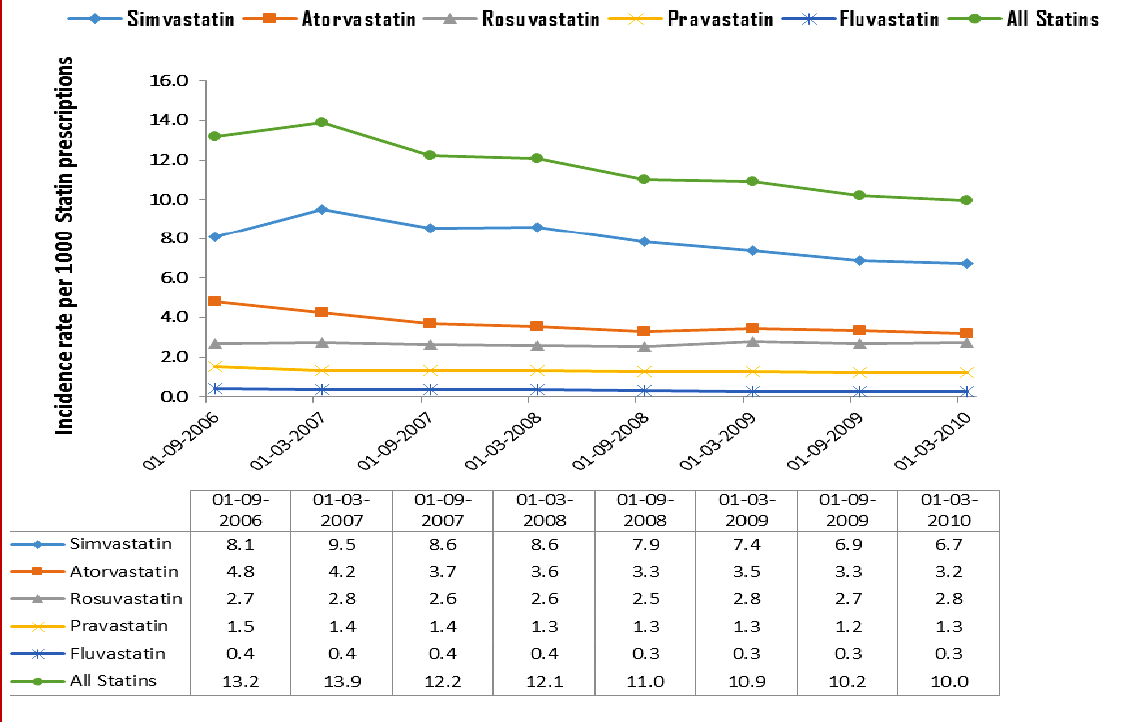
Figure 2: Incidence rate per thousand statin prescriptions in Scotland from 2005 to